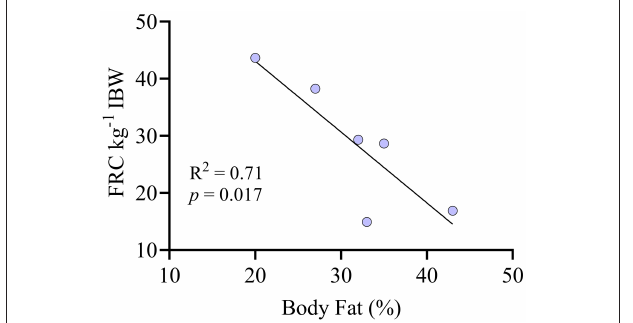
FIGURE 2 | Correlation between the percentage of body fat and the functional residual capacity (FRC) indexed by ideal body weight (kg) in six anesthetized obese dogs undergoing CT